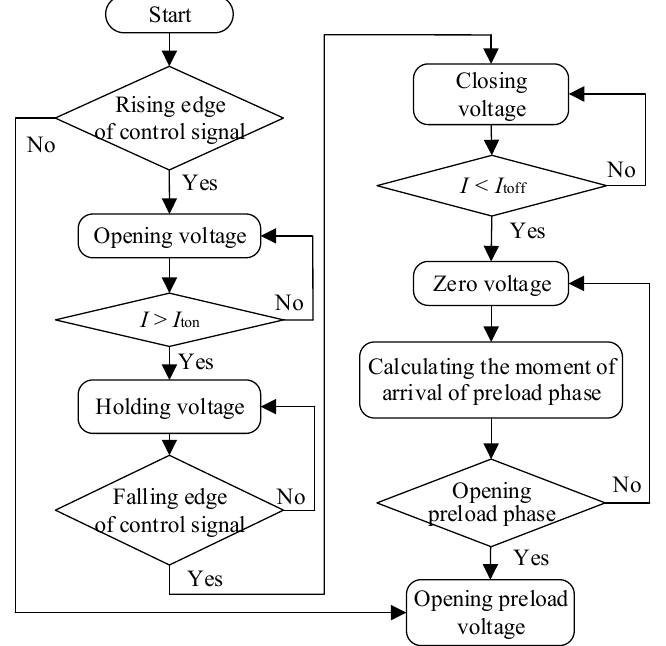
Figure 8. Flow chart of pre-existing multi-voltage control.